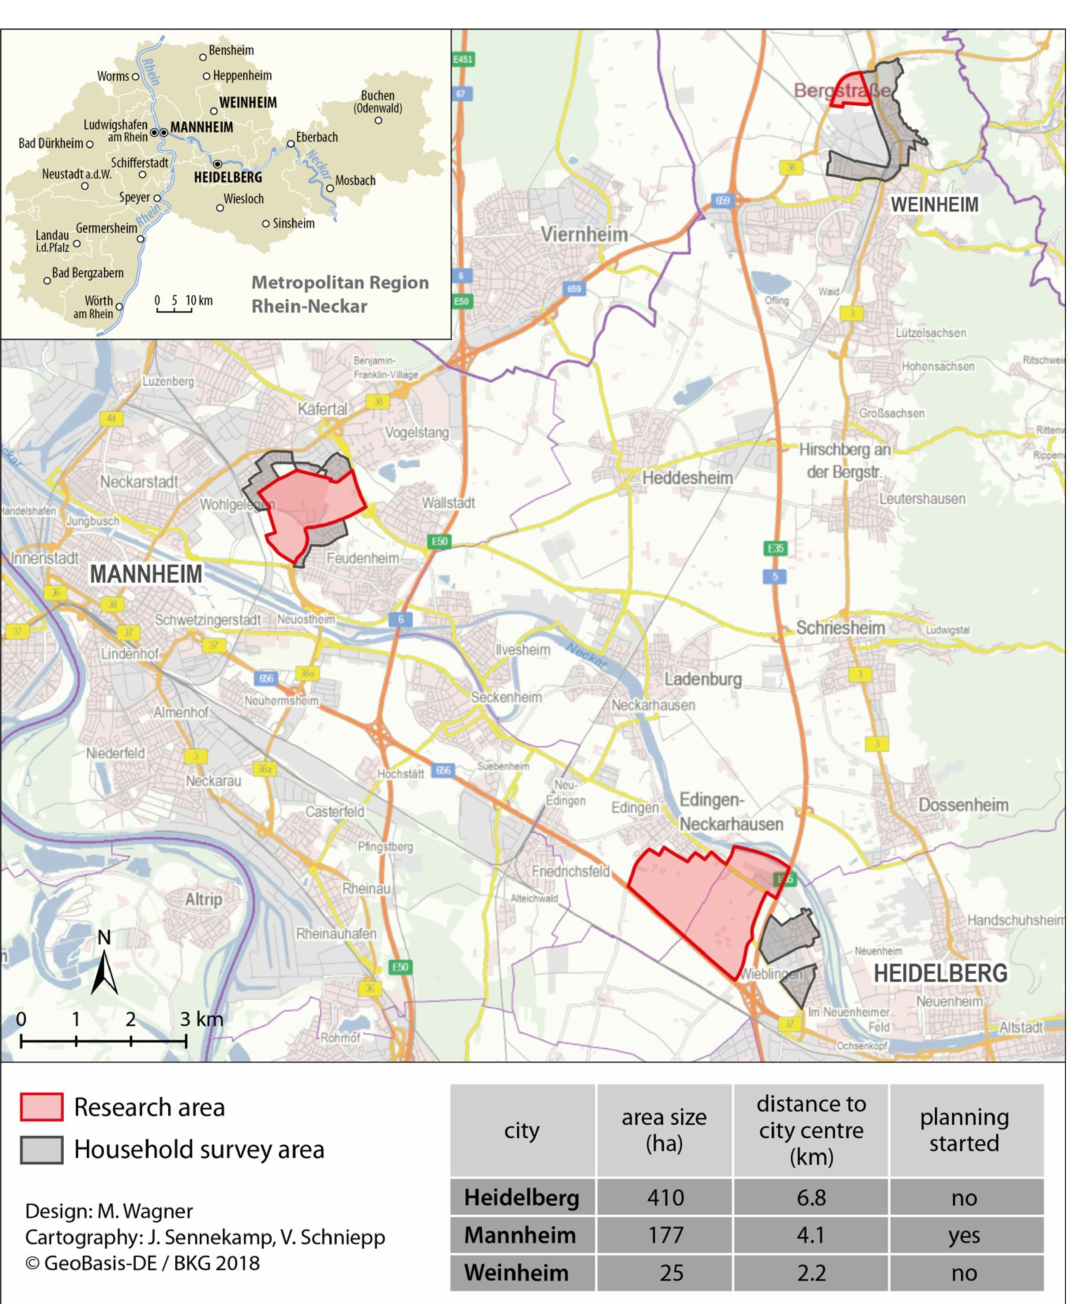
Figure 1. Research areas in the metropolitan region Rhein-Neckar. Own